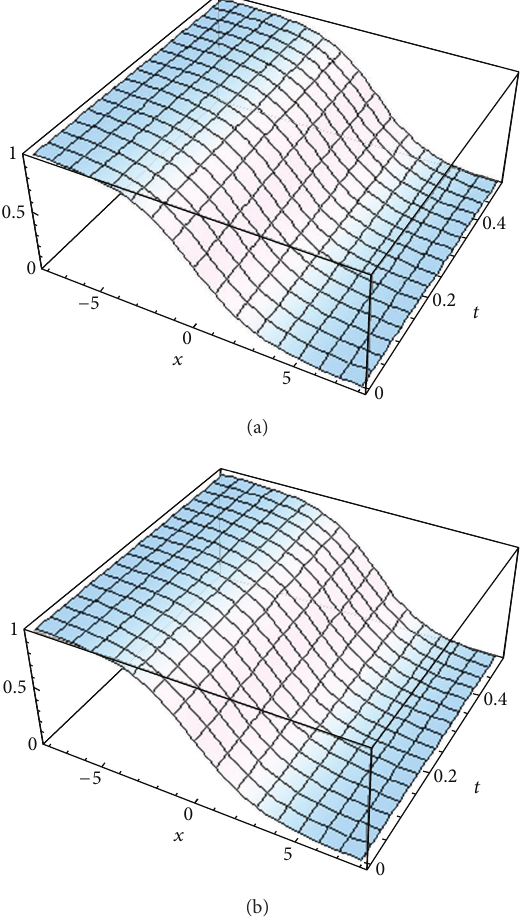
(3,0.1)| , (b) absolute Figure 6: (a) Absolute error |𝑢(3,0.1) − 𝑢 app (7, 0.3)| , for FN equation, with 𝑛 = 11 , when error |𝑢(7, 0.3) − 𝑢 app −8 ≤ 𝛼 ≤ 8 .